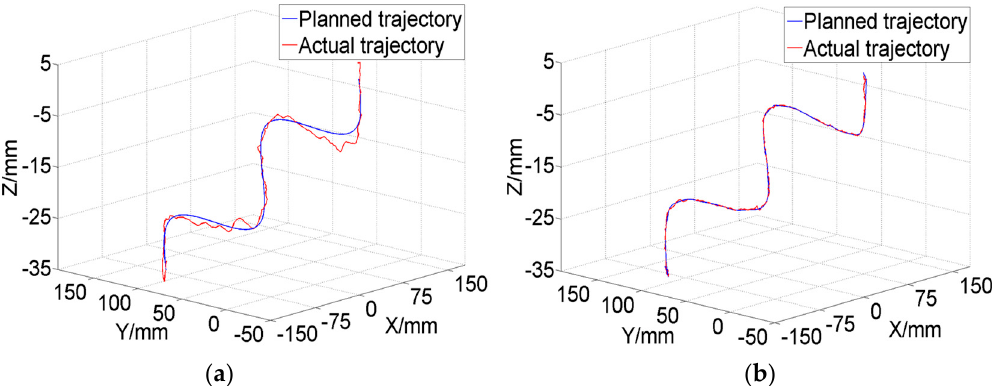
Figure 11. Comparison of experimental results of the GVF. ( a ) Without GVF constraint; ( b ) with GVF constraint.